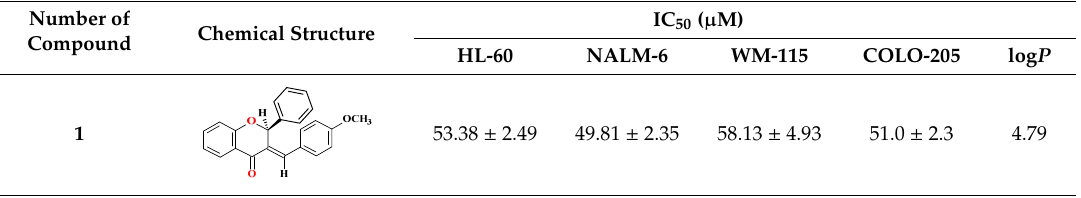
Table 3. The lipophilicity values and cytotoxic activity of compounds against HL-60, NALM-6, WM-115 and COLO-205 cancer cell lines. The results are presented as IC 50 values in the µ M